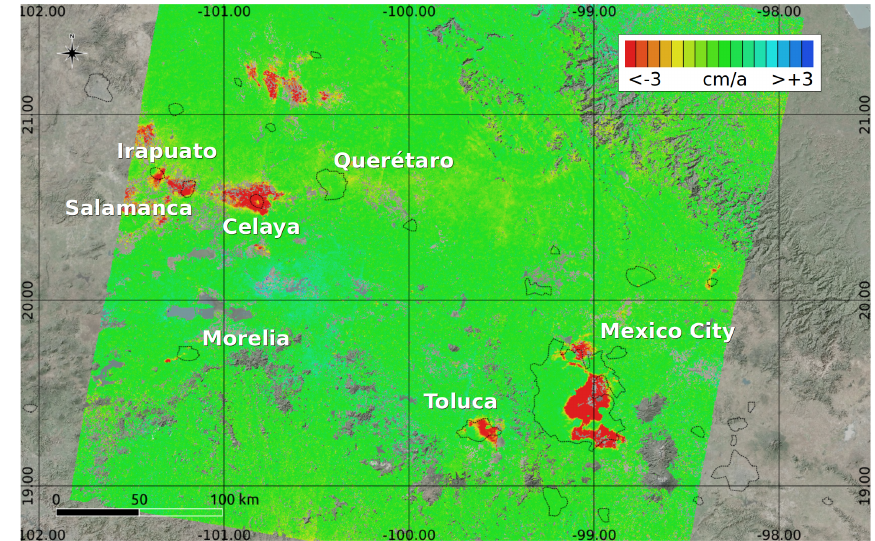
Figure 2. Land subsidence in central Mexico from ALOS-2 PALSAR-2 ScanSAR interferometry between 20 February 2015 and 16 Febru- ary 2018. Colour scale is saturated at 3cmyr − 1 . Map data are from Bing Aerial (© Microsoft), urban areas extents from MODIS data (Schneider et al.,